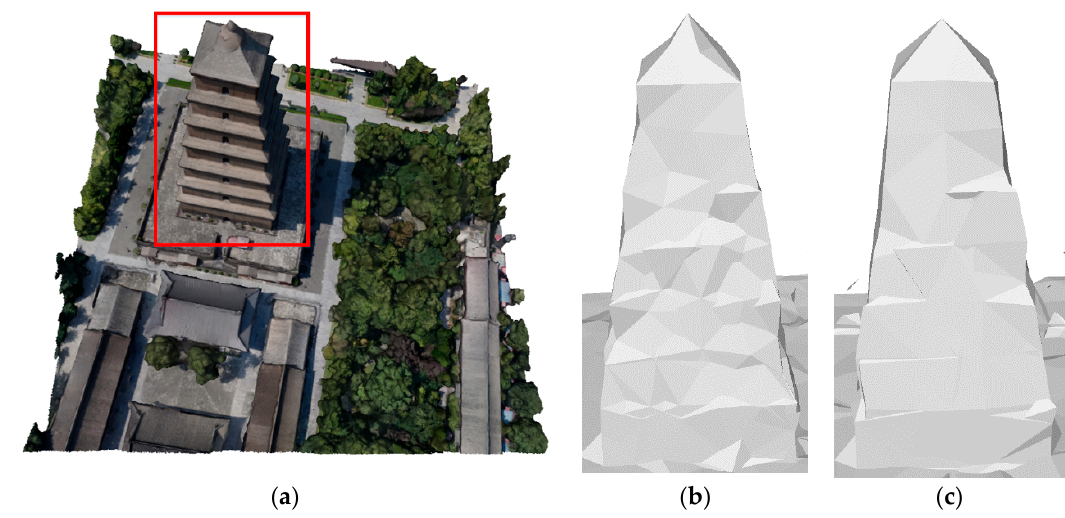
Figure A3. Simplification results at level 2 of tile A. The other simplification results are displayed in Figure 1. ( a ) Input surface with texture; ( b ) ACVD; ( c ) DVDC ( λ =